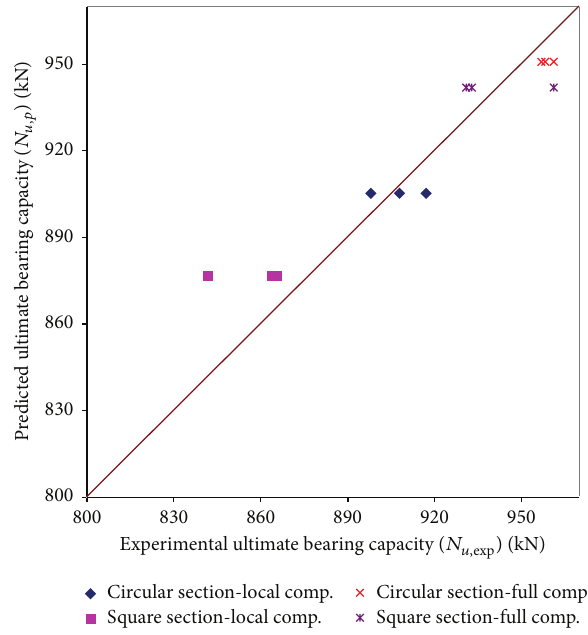
Circular section-local comp. Square section-local comp. Figure 13: Correlation between predicted and experimental ulti- mate strength of square and circular CFST column subjected to partial